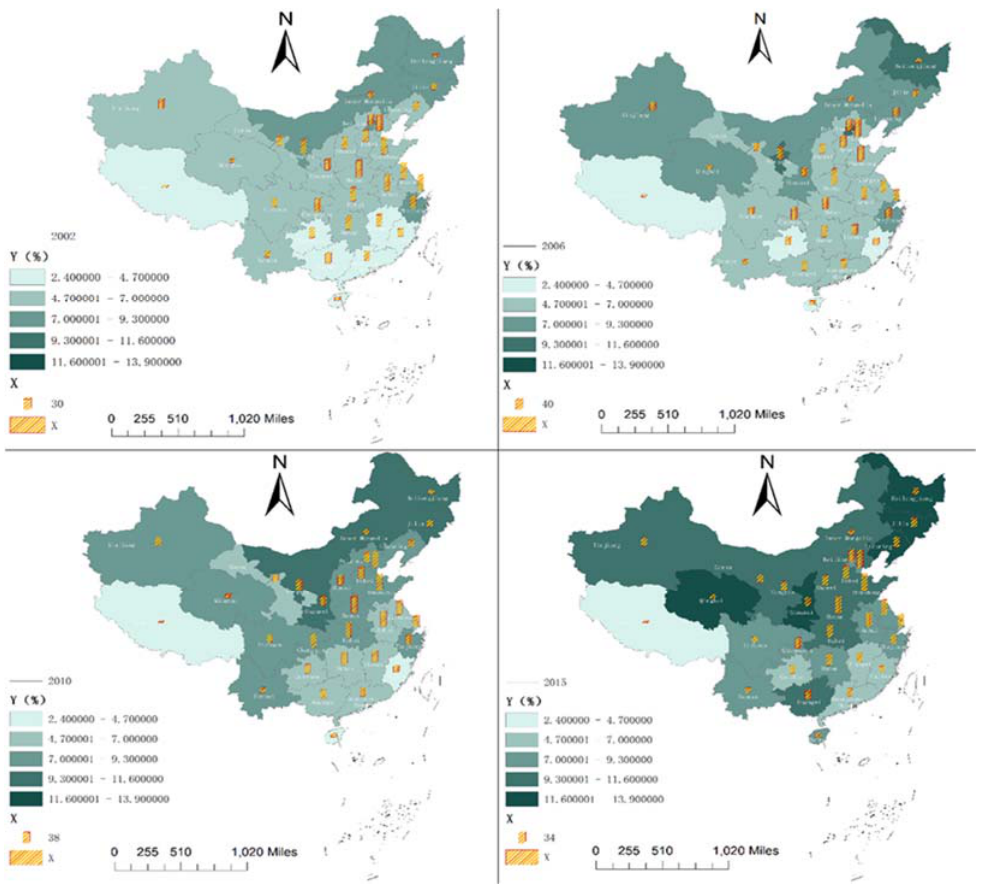
Figure 1. Spatial distribution of AAC-PM2.5 and HE-RR in China in 2002, 2006, 2010, and 2015. AAC-PM2.5 increased year by year from 2002 to 2015, and there were also differences among provinces, among which, the lowest concentration of PM2.5 in Tibet. In 2002, PM2.5 high concentration provinces were concentrated in Heilongjiang, Jilin, and Inner Mongolia in Northeast China; By 2006, AAC-PM2.5 of Heilongjiang Province was further deepened, and the PM2.5 pollution in Xinjiang, Qinghai, Ningxia, and Shaanxi was further strengthened; In 2010, AAC-PM2.5 of each region continued to increase. By 2015, Qinghai, Heilongjiang, Jilin, and Shaanxi had become the most polluted area in China. In terms of the proportion of the health expenditure of rural residents to consumption expenditure, the difference between different years is not apparent, but in the same year, the proportion of the health expenditure of rural residents in Shandong, Henan, Jiangsu, Tianjin, and other places is significantly higher than that of other provinces in China. The proportion of the health expenditure of rural residents to the consumption expenditure shows a trend of decreasing from coastal areas to inland